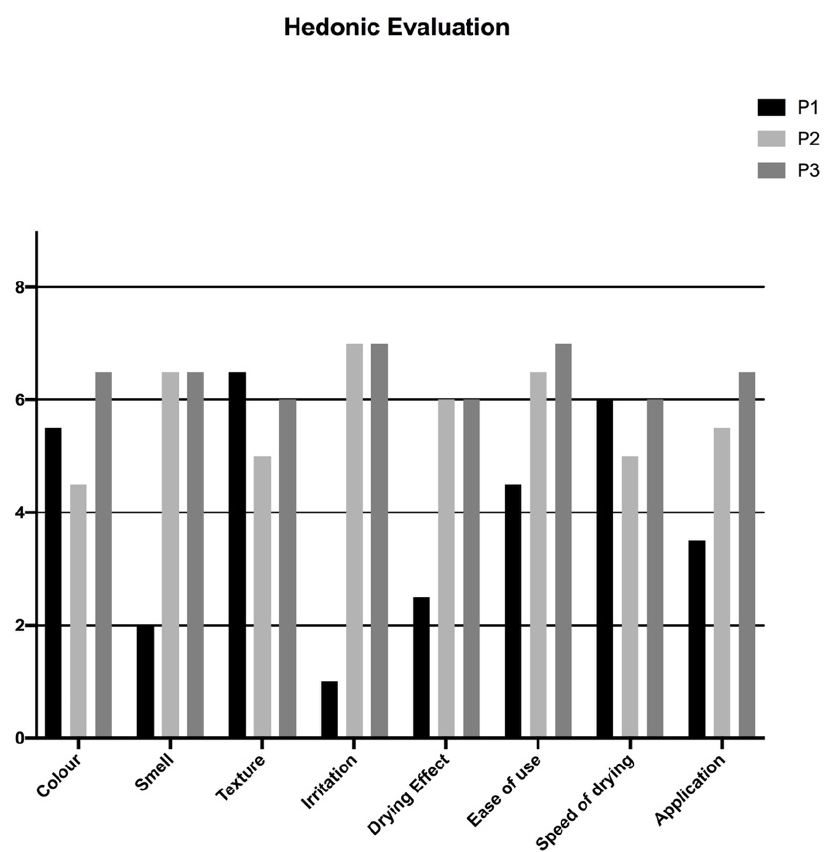
Figure 6. User acceptability for each of the alcohol-based hand rub (ABHR) products tested. Taking into consideration the parameters of the WHO Protocol [30] , P1 resulted in “acceptable” just for the color, with a score higher than 4 on 100% of volunteers, and “not acceptable” for all the other items. Thus, overall, the